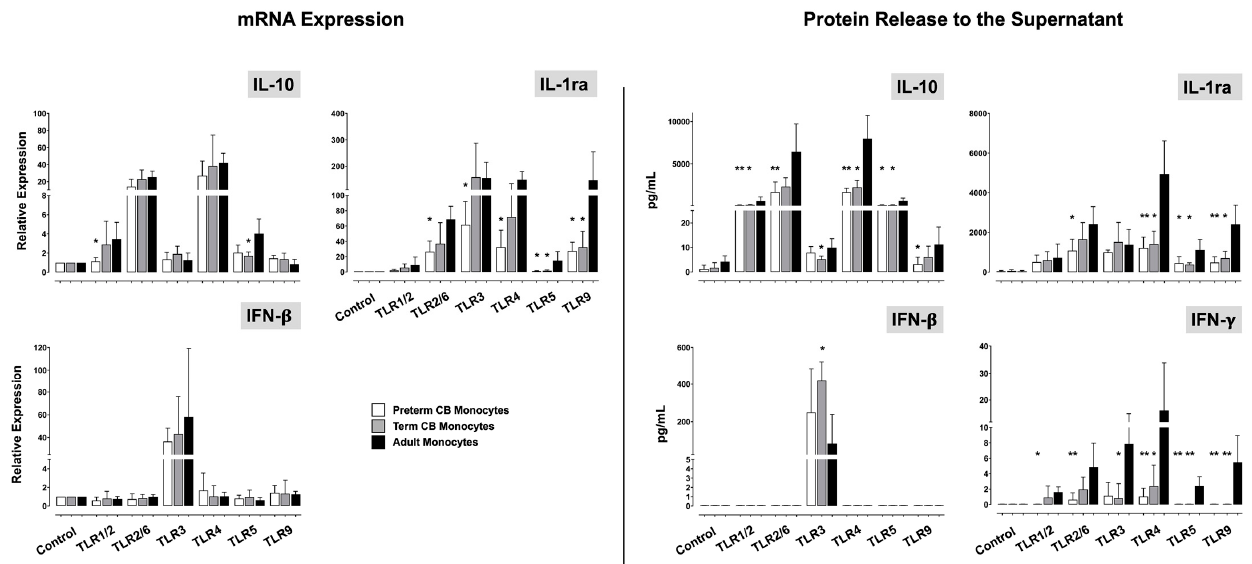
Figure 2. Anti-inflammatory IL-10 and IL-1ra, and IFN responses in TLR-stimulated preterm CB (white bars), term CB (grey), and adult monocytes (black). Unstimulated monocytes served as controls (baseline expression). Immune responses were assessed at the transcriptional and the translational level using qPCR and bead-based multiplex assay (mean ± SD; * p < 0.05, ** p < 0.01, vs. adult monocytes). For IFN- γ response, protein data are not accompanied by mRNA data. Contrary to the other mediators assessed in this study, IFN- γ mRNA was weakly expressed at 4 h incubation time throughout the study groups and CT values >30 did not allow for valid quantification.